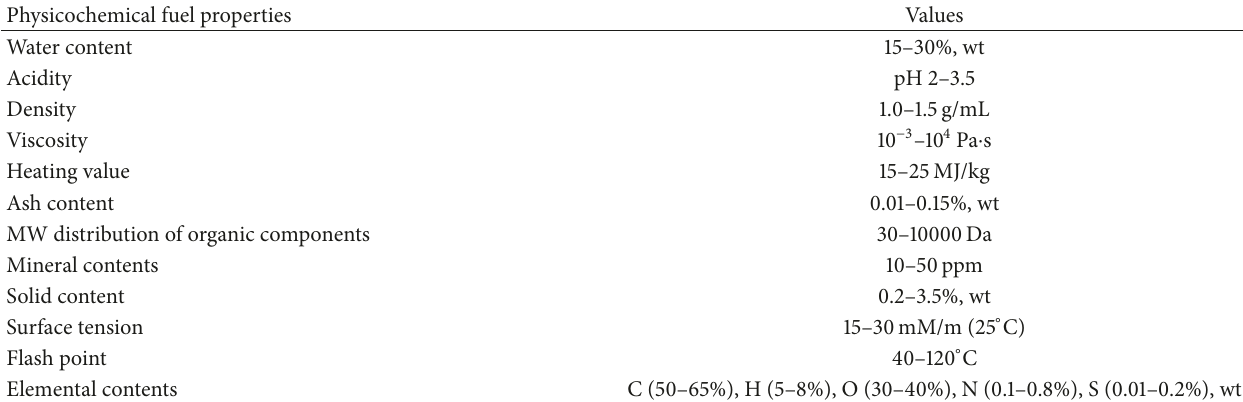
Table 2: Typical values for the bulk physicochemical fuel properties of